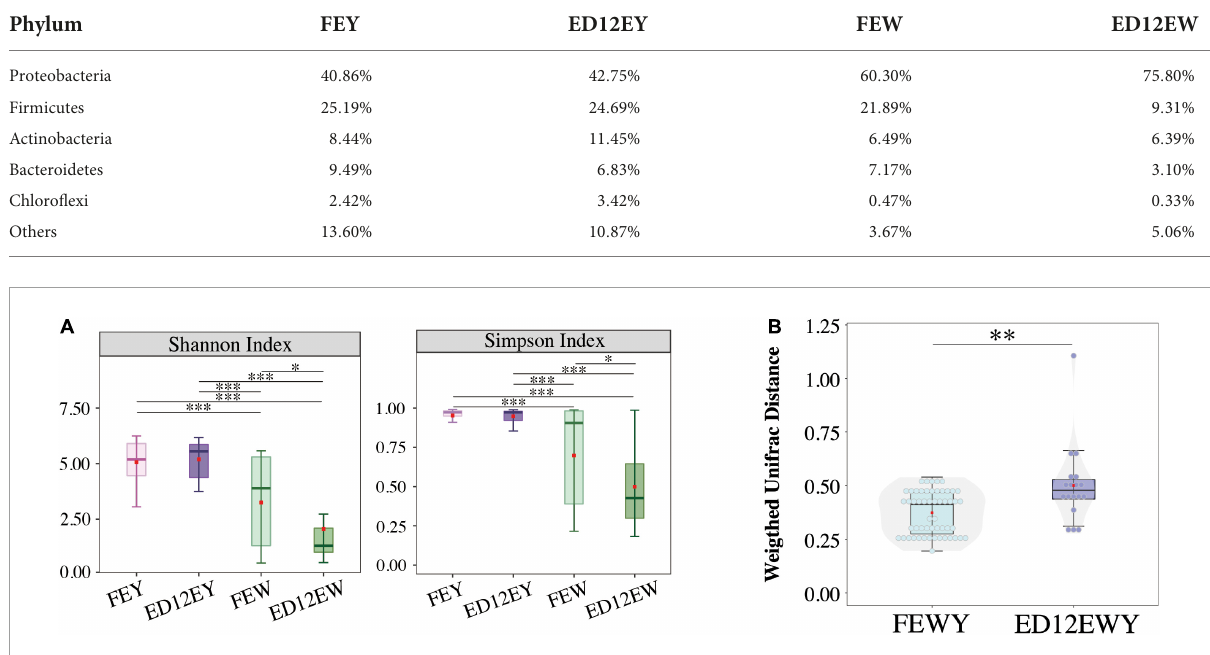
FIGURE4 Microbial diversity of each group. (A) Alpha-diversity (Shannon and Simpson indexes) of microbiota in four groups exhibiting community diversity. (B) The changes between egg yolks and whites on Microbial weighted UniFrac distance. FEWY represents fresh egg yolks and whites and ED12EWY represents egg yolks and whites at 12 embryonic ages. * P < 0.05, ** P < 0.01, *** P <